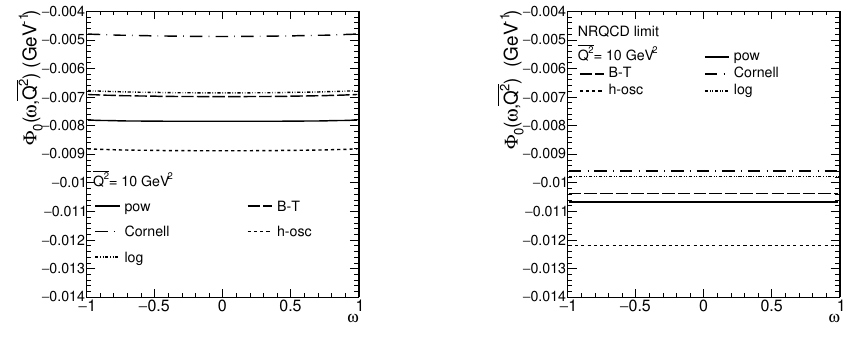
Figure 3 . Invariant form factor Φ 0 as a function of asymmetry parameter with fixed ¯ Q 2 = 10 GeV 2 , on the l.h.s. within LFWF approach, and on the r.h.s. in the nonrelativistic limit.